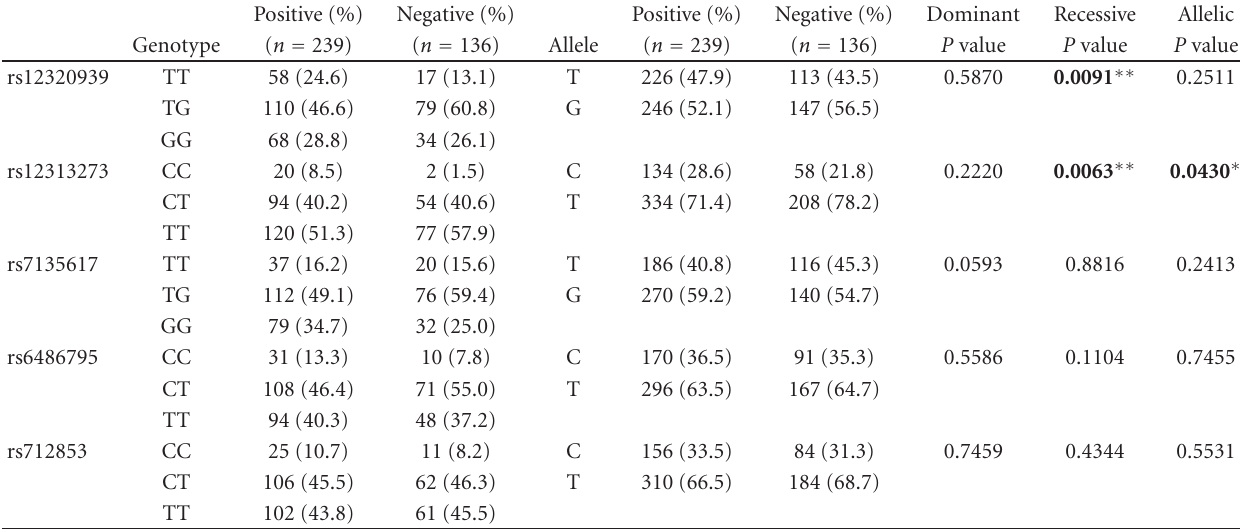
Table 4: Genotyping and allele frequency of ORAI1 gene in patients with breast cancer with di ff erent estrogen receptor (ER)